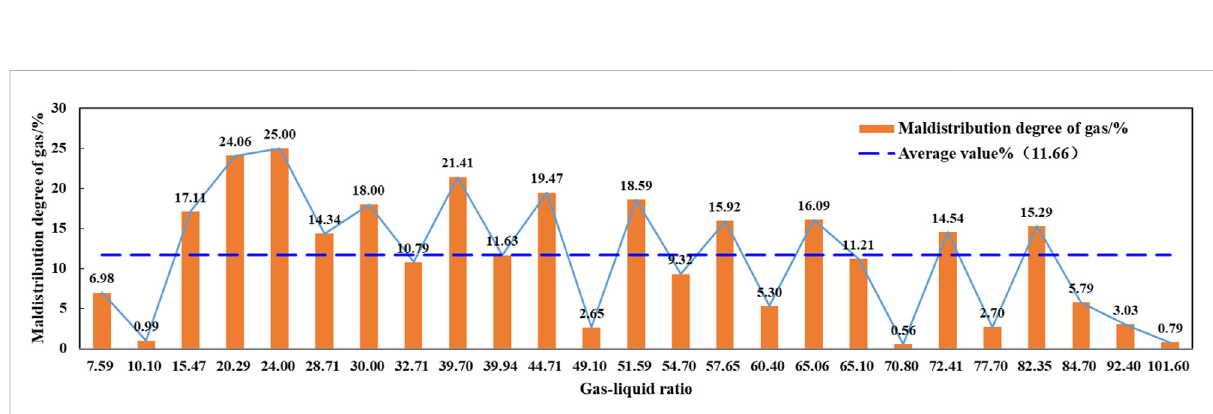
FIGURE 7 Histogram of gas – liquid ratio and maldistribution degree of gas in strati fi ed fl ow in horizontal manifold with fl ute pipes (liquid injection volume 0.10L/s+0.17L/s).